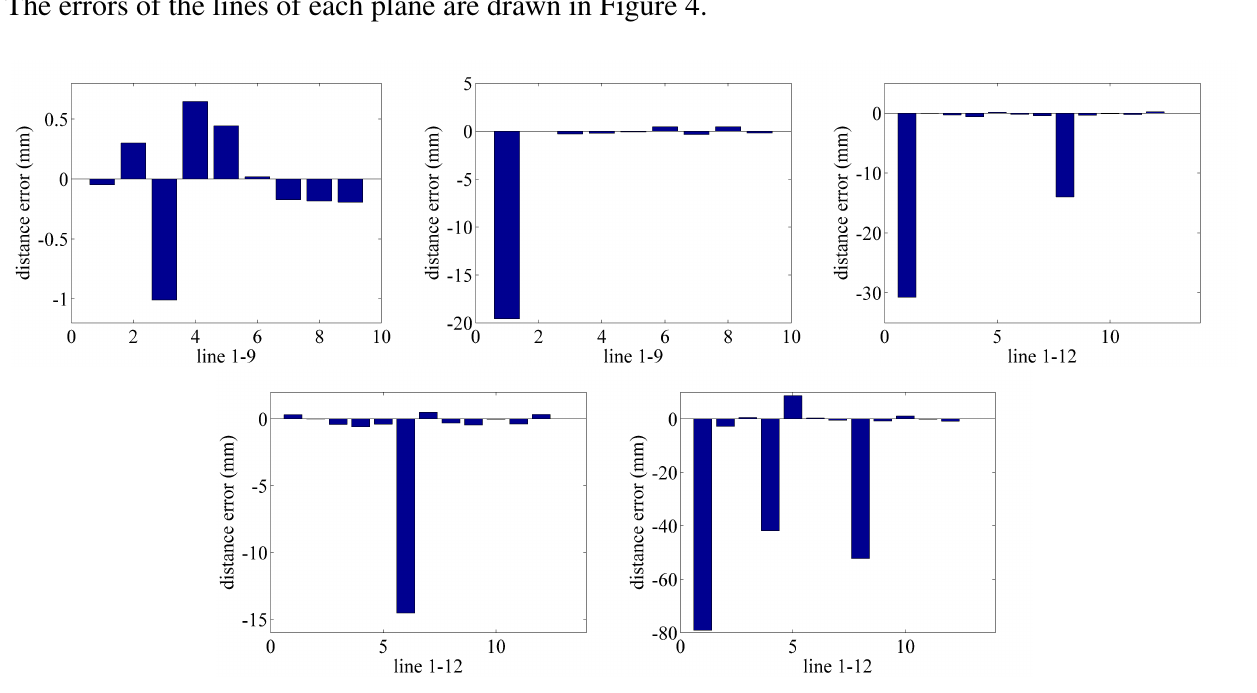
Figure 4. The error of the lines of five